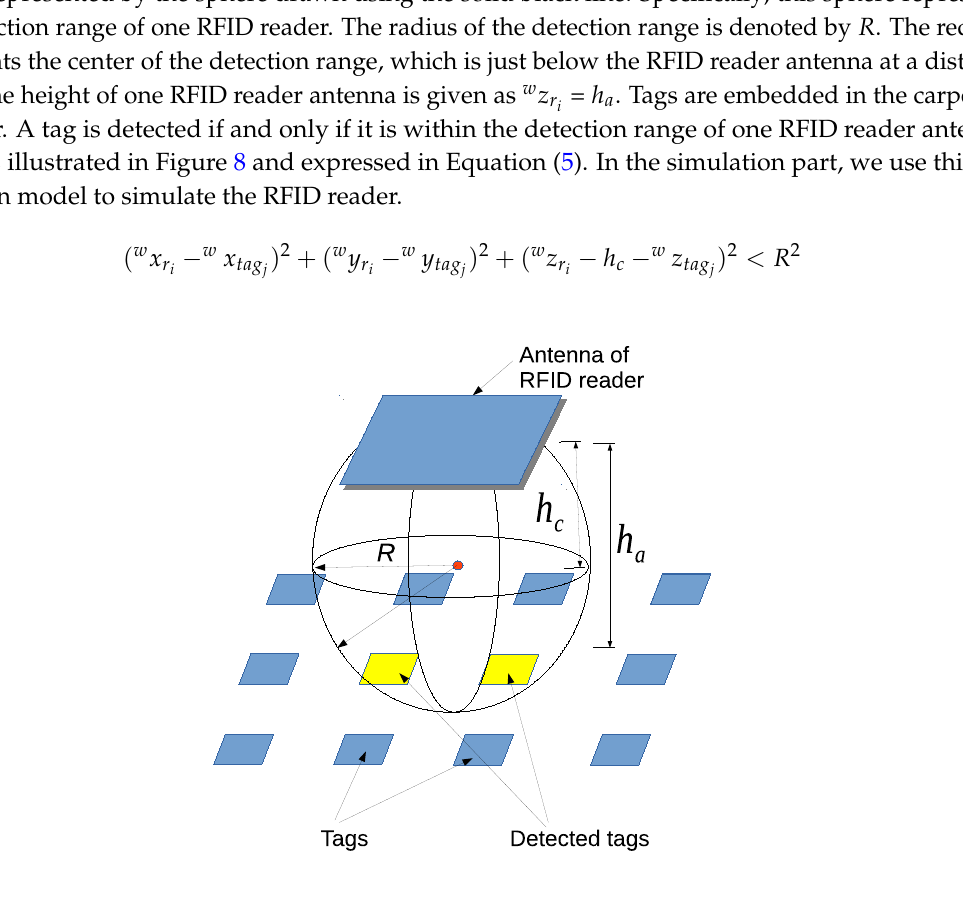
Figure 8. ID tag detection model for a small-sized RFID reader